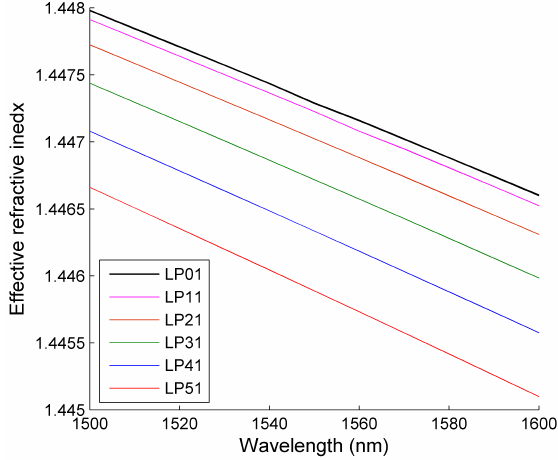
Figure 12. The calculated dispersion curve for the first six core modes of the optical fiber.